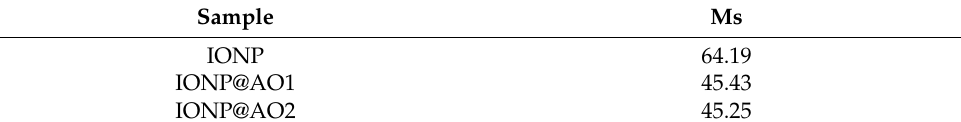
Figure 5. XRD spectra unfunctionalized IONP and functionalized IONP@AO.